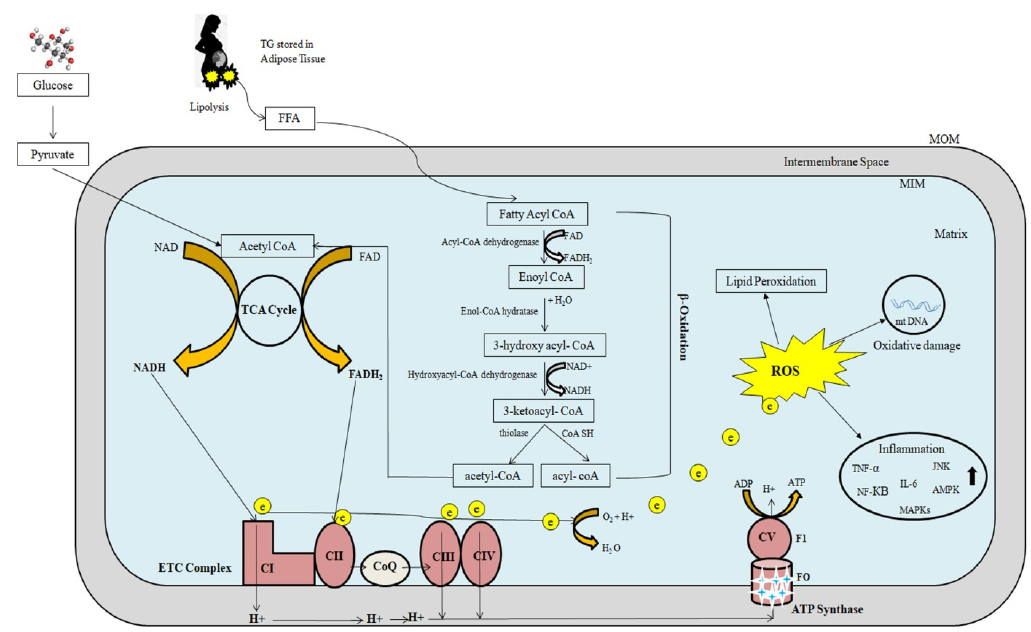
Figure 2. The role of mitochondria in fatty-acid oxidation and energy production. Excessive electron leakage causes excessive ROS generation and cellular injury. FFA: Free fatty acid; NADH: Nicotinamide adenine dinucleotide; FADH: Flavin adenine dinucleotide; ROS: Reactive oxygen species; ETC: Electron transport chain; MOM: Mitochondrial outer membrane; MIM: Mitochondrial inner membrane; ADP: Adenosine diphosphate; e: electrons; ATP: Adenosine triphosphate; TNF- α : Tumor necrosis factor- α ; NF-KB: Nuclear factor-KB; IL: Interleukin; MAPKs: Mitogen activated protein kinases; JNK: c-jun N terminal kinase; AMPK: AMP-activated protein kinase. Three types of acyl-CoA dehydrogenases are known to play roles in FAO in humans: very-long-chain, medium-chain, and short-chain acyl-CoA dehydrogenases (VLCAD, MCAD, and SCAD, respectively). These three enzymes work together to convert long- chain acyl-CoAs to medium-chain acyl-CoAs and then to short-chain acyl-CoAs. MCAD and SCAD are soluble, matrix-localized enzymes, while VLCAD is associated with the inner mitochondrial membrane. Mitochondrial trifunctional protein (MTP) is a complex enzyme that contains three enzymatic activities: long-chain enoyl-CoA hydratase, 3-hy- droxyacyl-CoA dehydrogenase, and 3-ketothiolase. The α -subunit contains long-chain enoyl-CoA hydratase (LCEH) and long-chain 3-hydroxyacyl-CoA dehydrogenase (LCHAD), while the β -subunit contains long-chain 3-ketoacyl-CoA thiolase (LCKAT). MTP is bound to the inner mitochondrial membrane. The matrix-localized enzymes MCAD, crotonase (enoyl-CoA hydratase), MCHAD, and MCKAT manage the resulting medium-chain acyl-CoAs. Finally, SCAD, crotonase, SCHAD, and MCKAT metabolize short-chain acyl-CoAs. 3.2.3. Oxidative Phosphorylation The main source of cellular energy is the electron transport chain (ETC) and oxidative phosphorylation through critical activities of protein complexes in the inner mitochon- drial membrane. High-energy electrons released during the citric acid cycle and β -oxida- tion are captured by nicotinamide adenine dinucleotide (NAD) and flavin adenine dinu- cleotide (FAD), resulting in NADH and FADH 2 , respectively [47]. NADH and FADH 2 molecules donate these high-energy electrons to the ETC [48]. The transfer of electrons to O 2 is an energy-yielding reaction by the passage of electrons through a series of carriers,